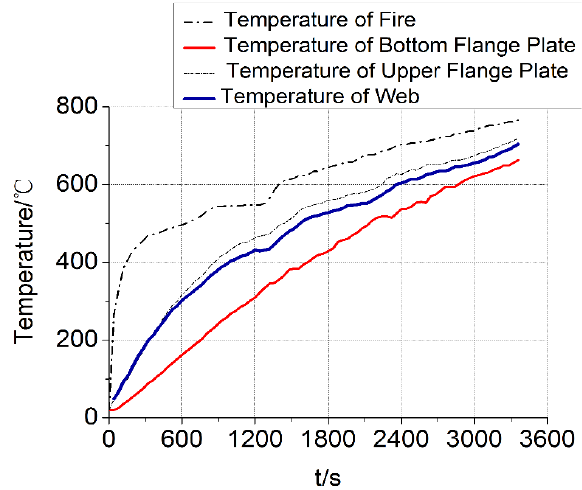
Buildings 2022 , 12 , x FOR PEER REVIEW Figure 15. Loading temperature curves versus time . Figure 15. Loading temperature curves versus time.